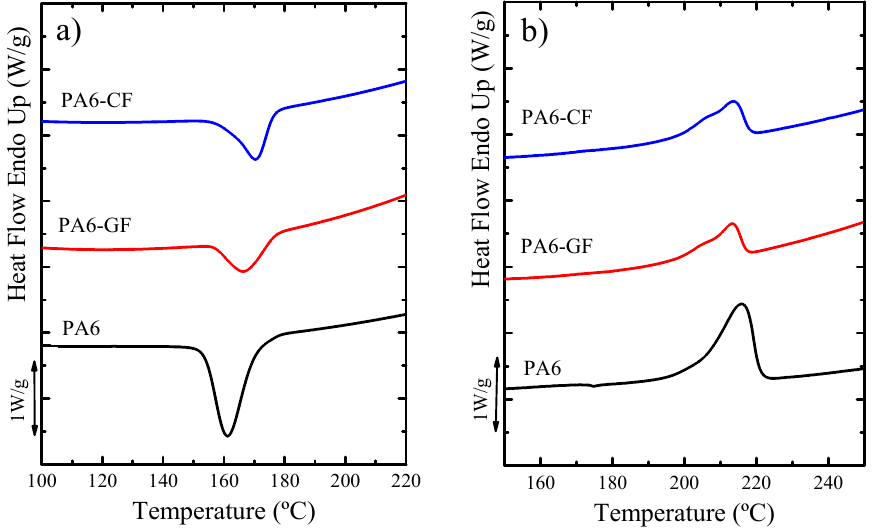
Figure 4. DSC ( a ) cooling and ( b ) heating curves of polyamide 6 and polyamide 6 composites at 20 ◦ C · min − 1 rate. Scans presented in the image are not standardized by the weight fraction of PA6. SAXS / WAXS—Crystalline